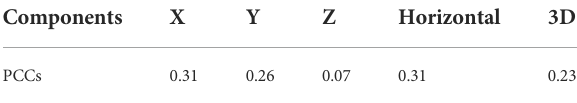
TABLE 1 PCCs between smoothed curvature and AF PGA .